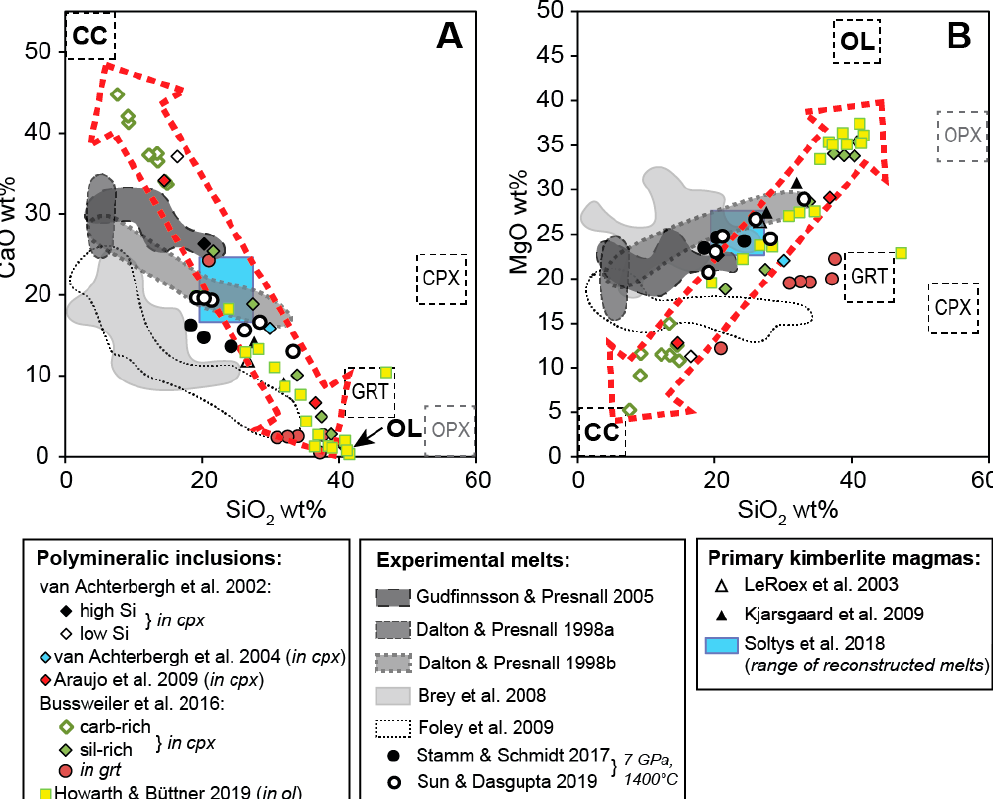
Figure 5. Reconstructed bulk compositions of polymineralic inclusions from various studies (see legend) plotted together with experimental melts (shaded fields), estimates of primary kimberlite magmas from natural kimberlites (triangles), and end-member compositions of calcite (cc), olivine (ol), garnet (grt), clinopyroxene (cpx), and orthopyroxene (opx) (modified after Bussweiler et al. [44]; their Figure 12). The blue rectangle represents the range of reconstructed primary compositions for South African kimberlites by Soltys et al. [20]. The CaO versus SiO 2 plot ( A ) and MgO versus SiO 2 plot ( B ) show that reconstructed bulk compositions of polymineralic inclusions mostly define compositional arrays (dotted red arrows) between the end-members cc and ol, which is probably a function of a sectioning effect. Possible primary compositions, i.e., from within the experimental melt fields, can be projected onto the polymineralic inclusion arrays by reaction with the host megacrysts, e.g., clinopyroxene or garnet. Reaction with / dissolution of orthopyroxene and olivine may play a role as well.